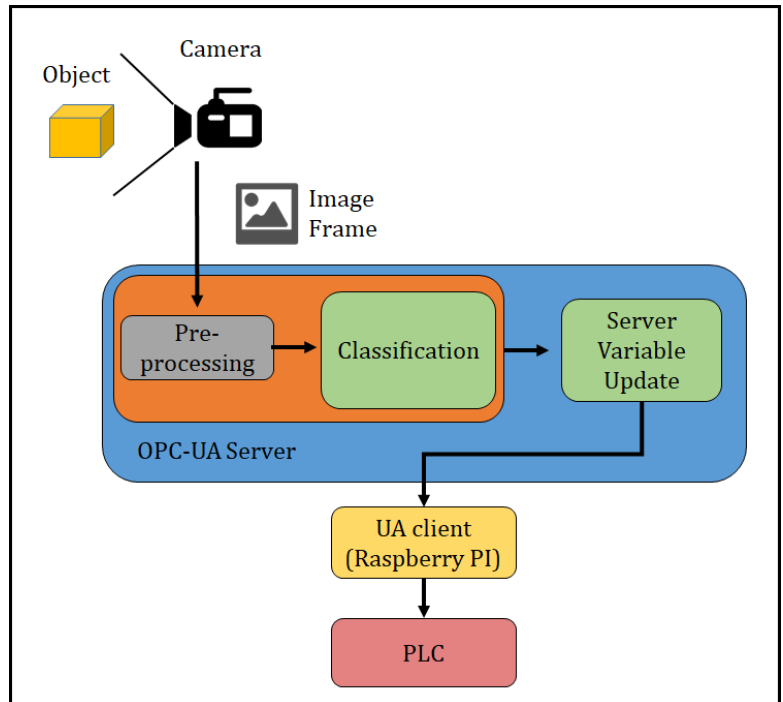
Figure 12. Camera to PLC through machine learning (ML) module signal travel time experiment set-up.